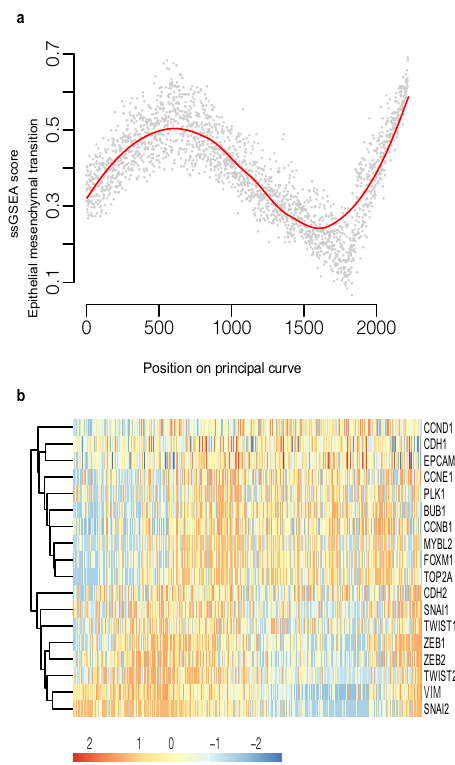
Fig. 5 Predominant Hallmark signatures that vary along the PCP continuum. a Single-sample Gene Set Enrichment Analysis (ssGSEA) score for the Epithelial to Mesenchymal transition Hallmark signature. Samples are ordered according to the principal curve projection. b Heatmap showing expression of key proliferation genes (CCND1 – Top2A) and key EMT (CDH2-SNAI2) genes. Samples were ordered according to the principal curve projection. Relative expression is provided as log 2 counts per million (CPM) minus the mean log 2 CPM for each